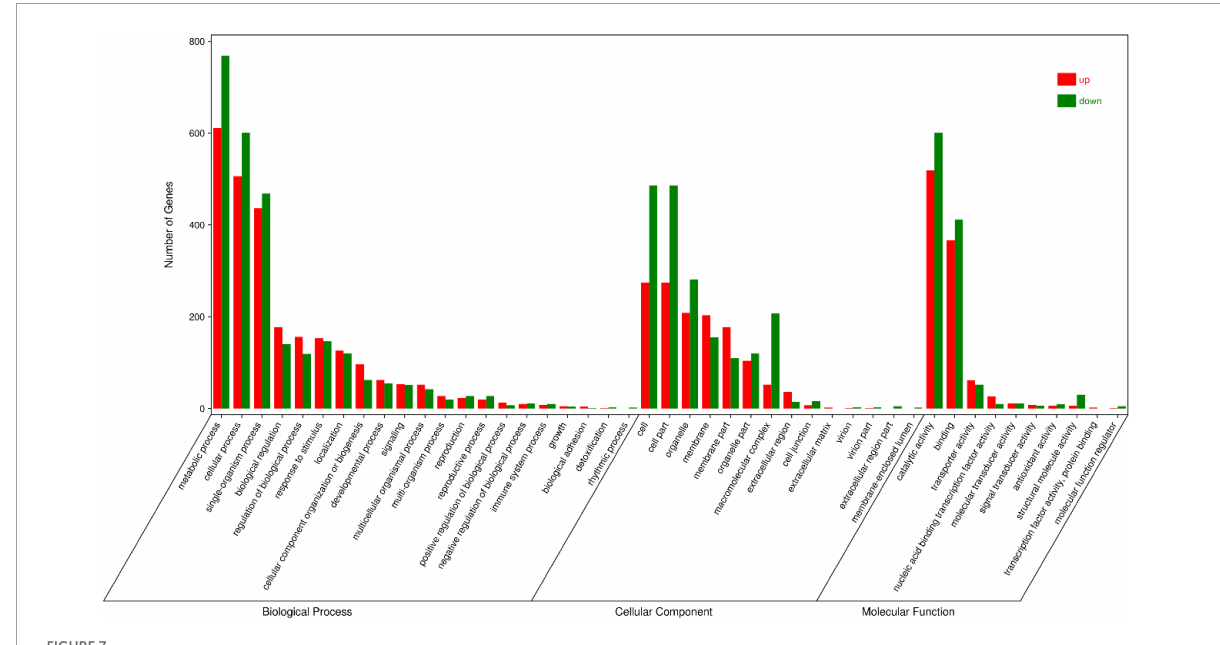
FIGURE7 Gene Ontology (GO) analysis of DEGs between WT and OE5.